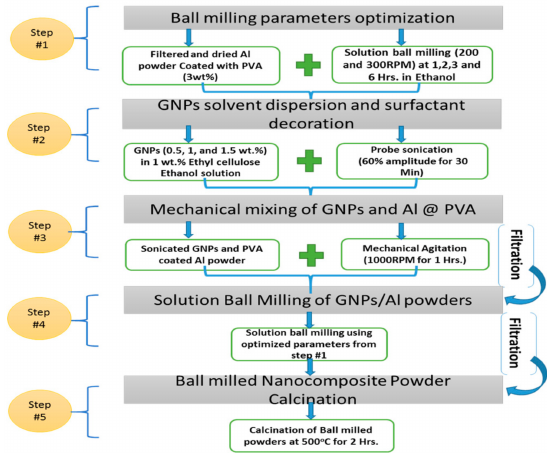
Figure 3. Solvent dispersion and ball milling (SDBM) processing for the fabrication of the GNPs/Al composite powder.